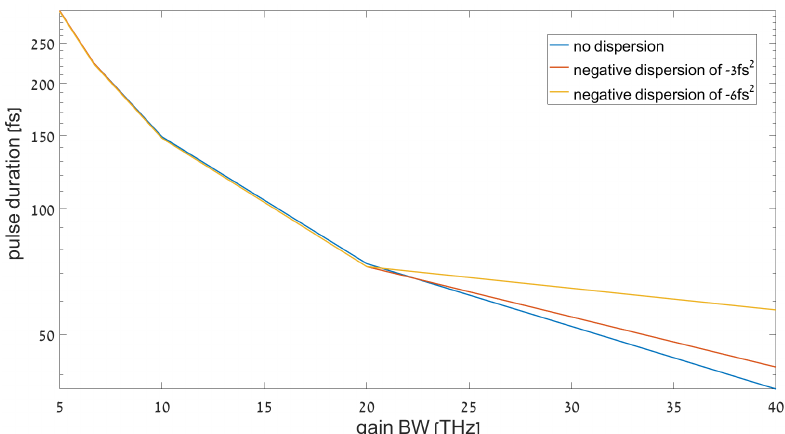
Figure 4. The temporal width of the pulse in time as function of gain bandwidth. As expected, the pulse becomes shorter and shorter as bandwidth increases. Furthermore, we see that dispersion broadens the pulse, with the pulse duration in the high dispersion configuration being almost an order of magnitude longer than the low dispersion